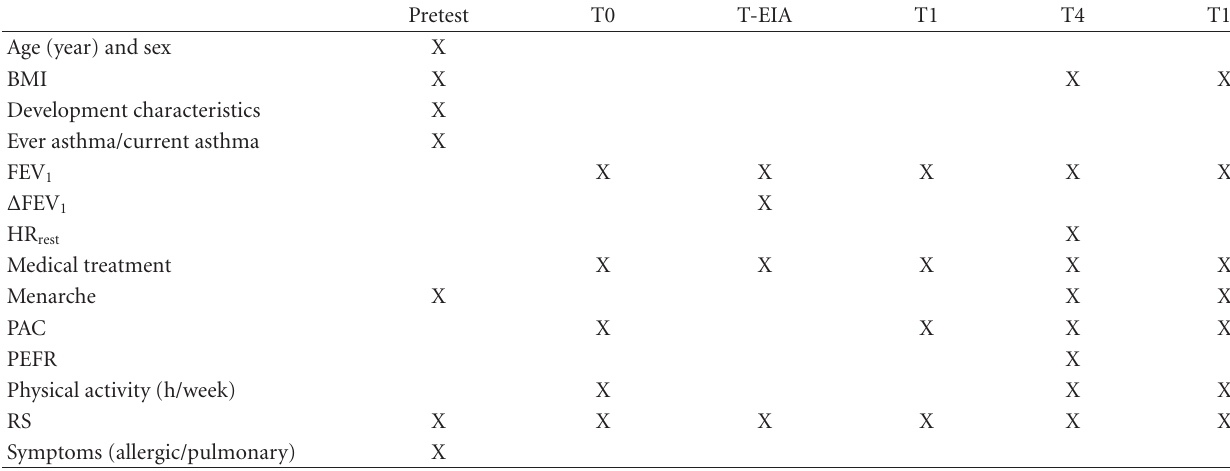
Table 1: Matrix of observations.